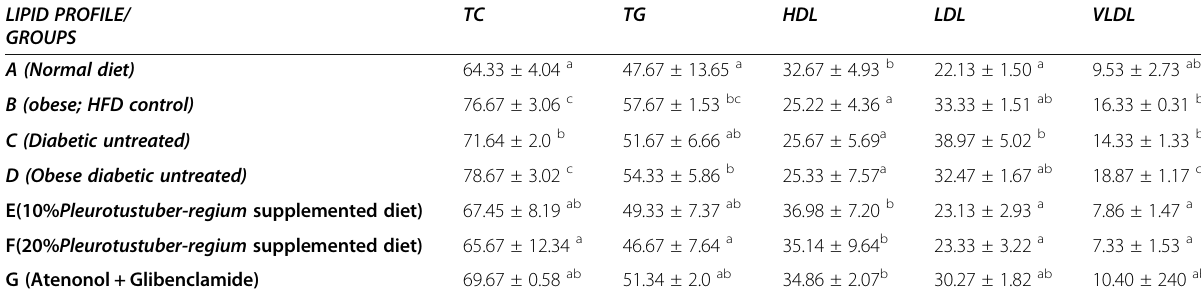
Table 10 Effect of Pleurotus tuber-regium supplemented diet on the lipid profile in the liver of the rats LIPID PROFILE/ GROUPS